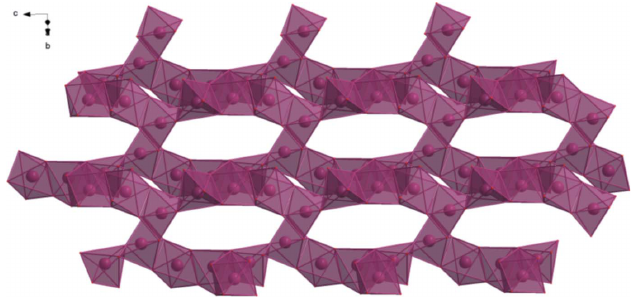
Figure 6 View of the Na/O layers in (I), viewed down [110].